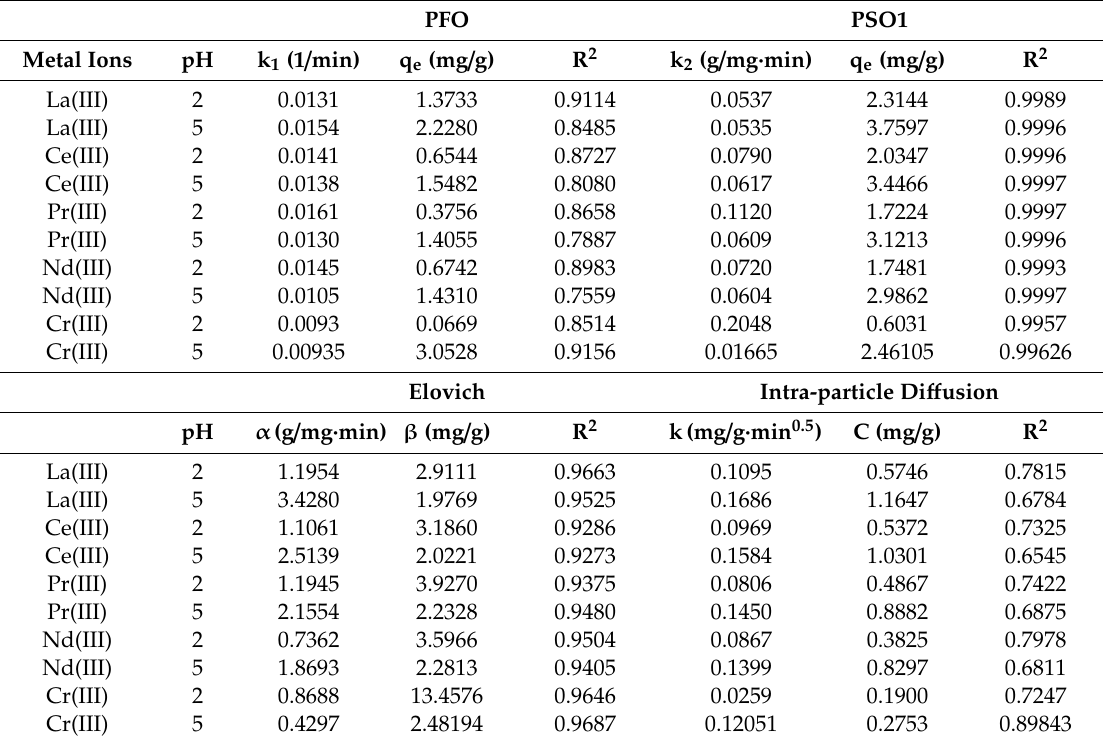
Table 3. The kinetic parameters for La(III), Ce(III), Pr(III), Nd(III), Cr(III) ions sorption. PFO PSO1 Metal